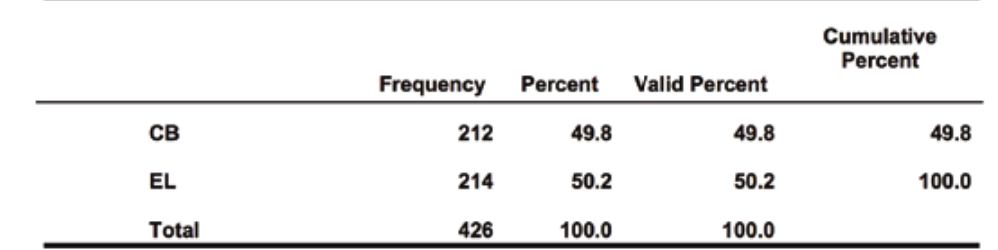
Age of majority of the students was in the range of 20-25 years (n=360, cumulative percentage of 84.50) while only 9.39% had ages between 26-30 year bracket. There were 18 respondents from age bracket 31-35 years. Only 8 students had age 36-40 years (1.88%). It is explained in below given table 2.